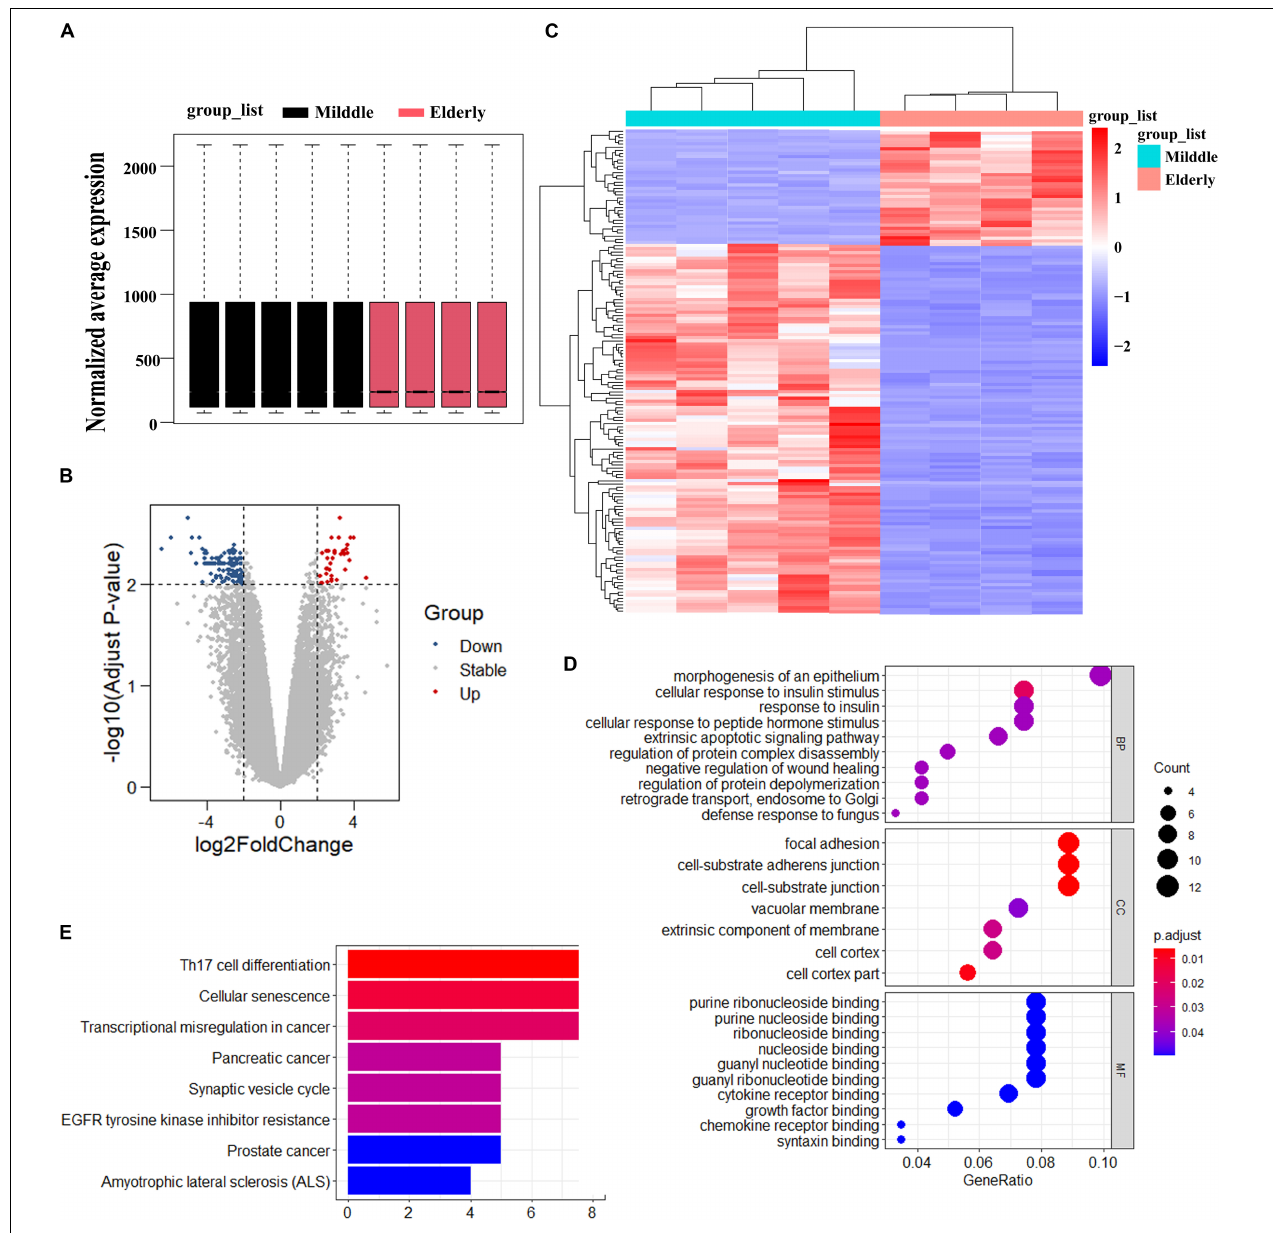
FIGURE 1 | Analysis of differentially expressed genes in BMSCs from middle-aged individuals and elderly aged individuals mined from GSE35955. (A) Boxplot of RNA-seq profiling of normalized mRNA expression in BMSCs. (B) Volcano Plot of normalized mRNA expression in BMSCs. (C) Heatmap of mRNA expression in BMSC. | Fold change| > 2, adjust p < 0.01. (D) GO (Gene Ontology) analysis of differentially expressed gene in the two groups. (E) KEGG (Kyoto Encyclopedia of Genes and Genomes) analysis of differentially expressed gene in the two groups. p <